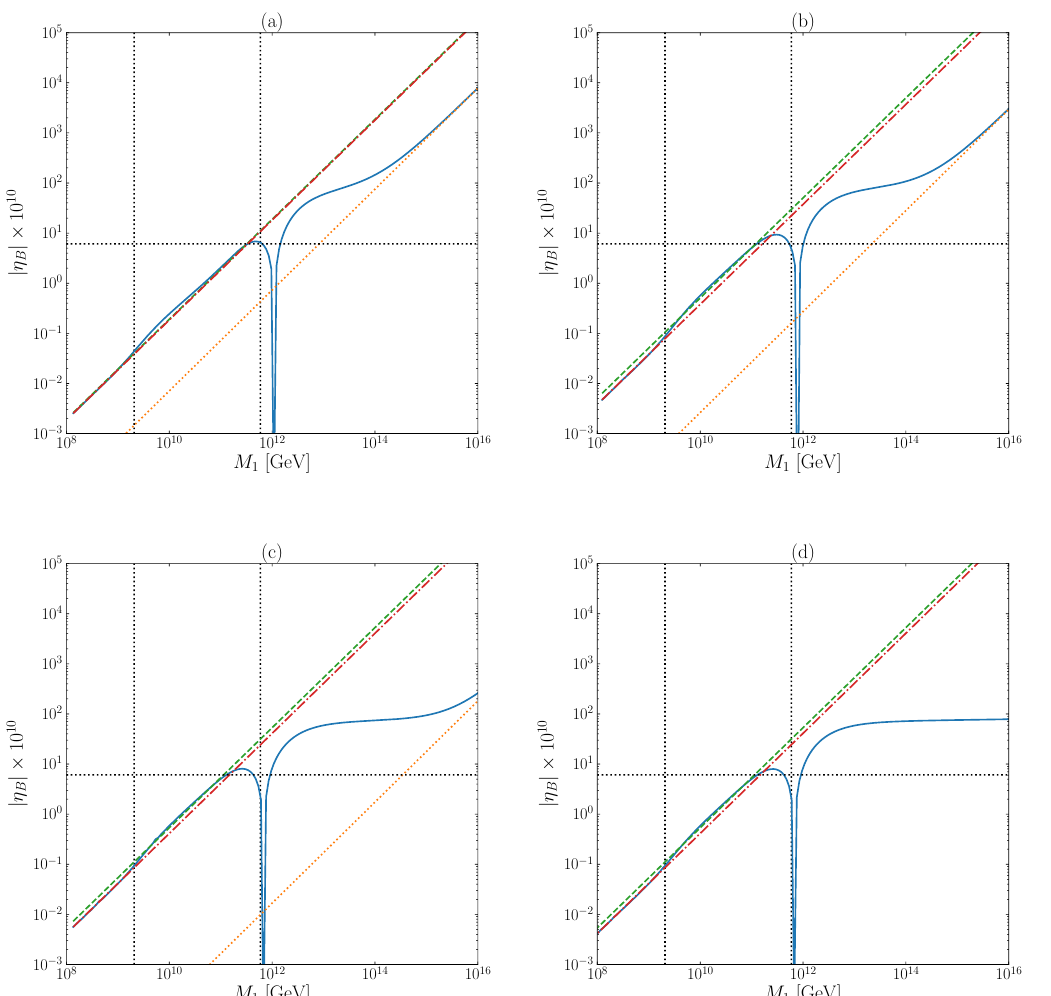
Figure 14 . The magnitude of the baryon asymmetry as a function of the heavy Majorana neutrino masses (assuming the modi(cid:12)ed Casas-Ibarra parametrisation) at a speci(cid:12)c point in parameter space. The dotted orange line corresponds to solutions of the single-(cid:13)avour Boltzmann equations, the dashed green line to those of the two-(cid:13)avour Boltzmann equation, the red dot-dashed line to those of the three-(cid:13)avour Boltzmann equations and the solid blue line to solutions of the density matrix equations. The horizontal black dotted line is the observed value of (cid:17) B and the vertical dotted CMB lines to the values of the muon and tau thermal widths. We vary y 3 such that in (a) y 3 = 30 (cid:14) , in (b) y 3 = 5 (cid:14) , in (c) y 3 = 0 : 3 (cid:14) and in (d) y 3 = 0 (cid:14) . As y 3 is the only complex parameter of the R -matrix for this parameter point, then plot (d) corresponds to the case of purely low-energy CP violation. As the CP violation becomes solely low energy (going from (a) to (d)), then the transition of the density matrix equations to the single-(cid:13)avour regime becomes longer. This culminates in an in(cid:12)nite transition width in plot (d) | a plateau in the baryon asymmetry for high-scale leptogenesis. The dip in all of the blue lines occurs as a consequence of the change in sign of the produced